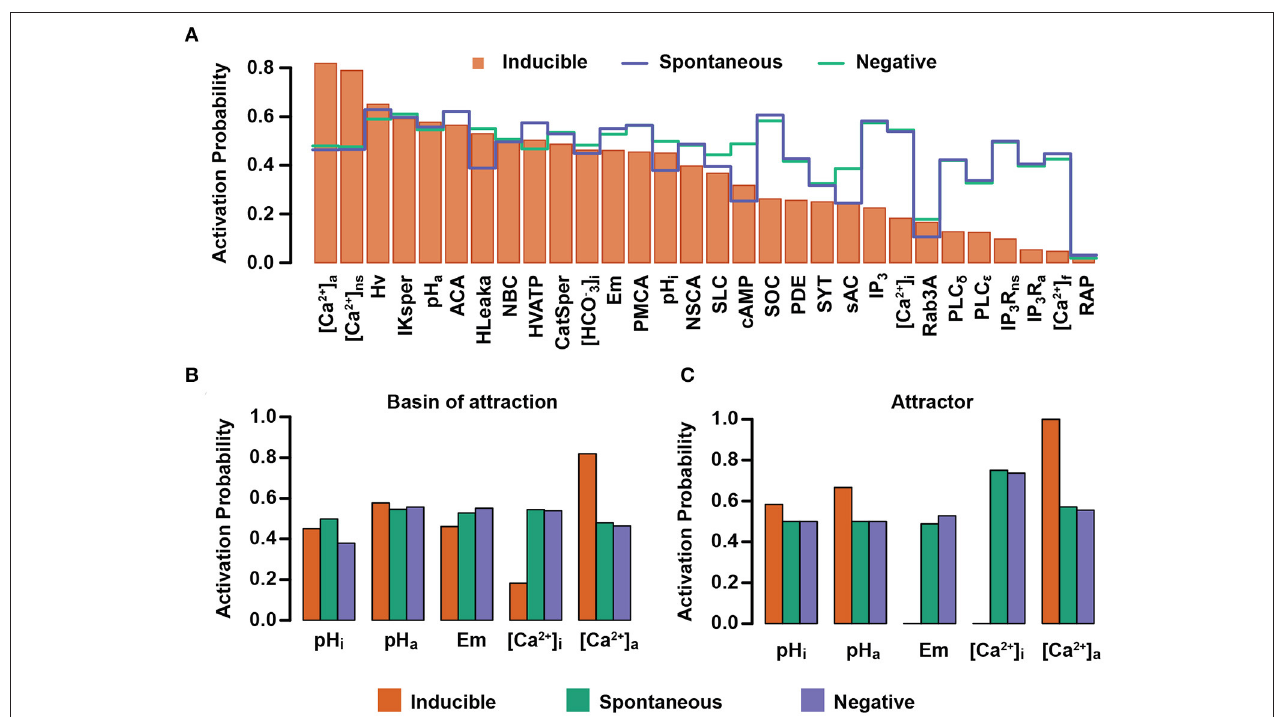
FIGURE 8 | Activation probability of network nodes in Inducible, Spontaneous, and Negative attractors. (A) Bars represent the activation probability of the network nodes for states in the Inducible attractors. Blue and green lines correspond to the activation probability of the network nodes in the Spontaneous and Negative attractors, respectively. (B,C) Activation probability of pH i , pH a , Em. [Ca 2 + ] i and [Ca 2 + ] a in the basins of attraction (B) or attractors (C) in the three functional